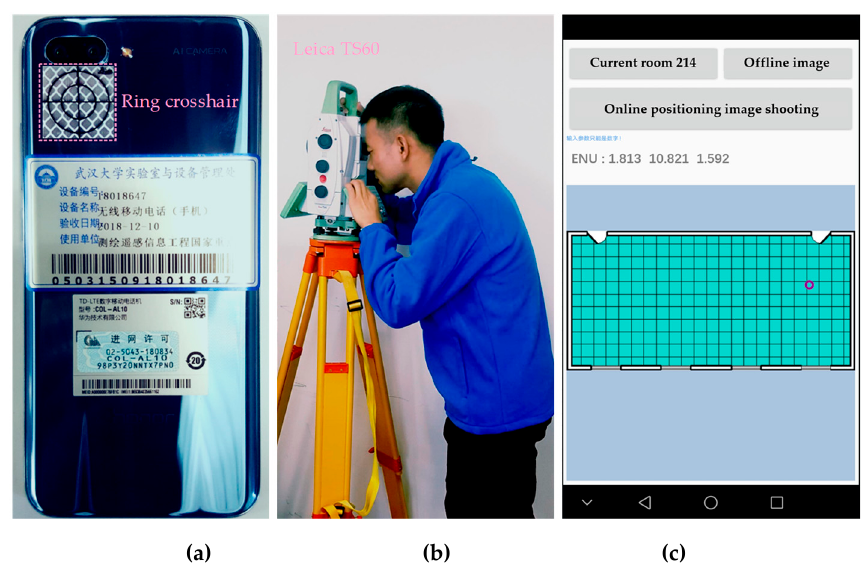
Figure 9. The real conference scene room. Remote Sens. 2019 , 11 , x FOR PEER REVIEW